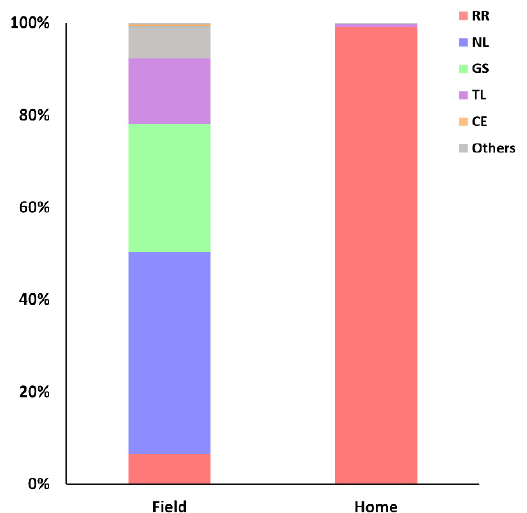
Figure 5. Proportion of species captured in field or household environments.